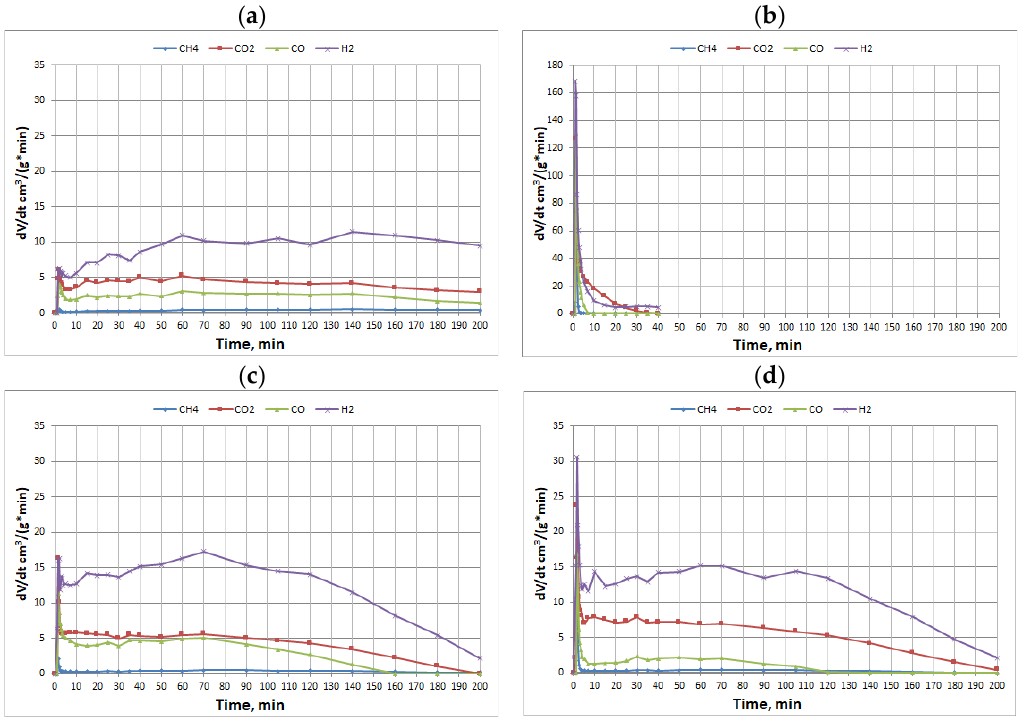
Figure 2. Changes in the formation rates of H 2 , CO, CO 2 , and CH 4 during steam gasification at 850 °C of ( a ) tire char, ( b ) sewage sludge, ( c ) a 90:10 blend, and ( d ) a 67:33 blend.